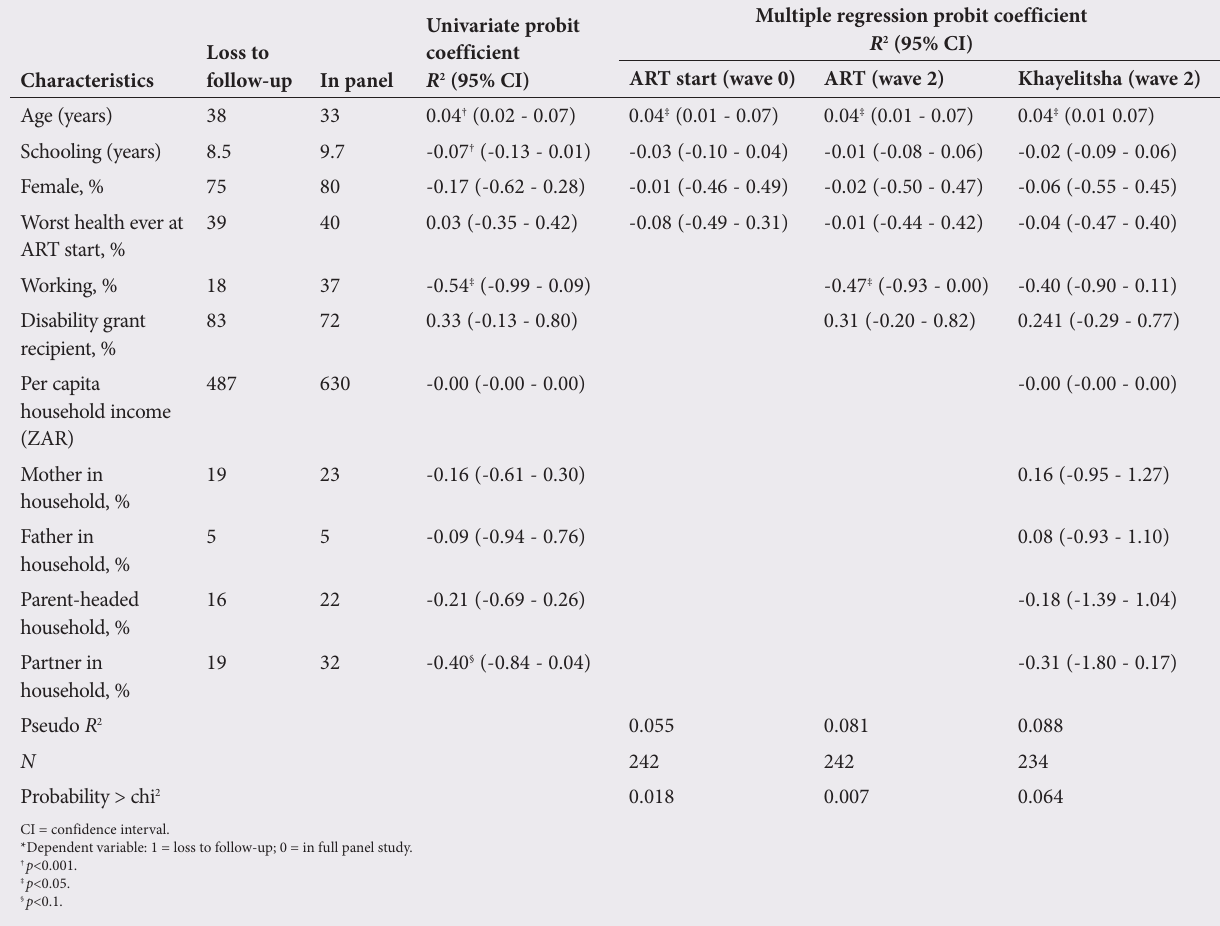
Table 1. Attrition analysis*